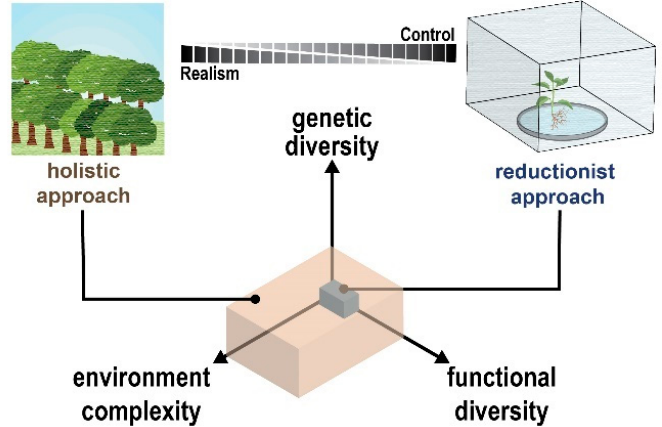
Figure 2. Dimensions of complexity and diversity in plant–microbe interactions. Studying plant– microbe interactions in both reduced and highly complex biological systems is necessary to obtain a complete understanding of these complex relationships. As complexity increases, the completeness and reliability of omic technologies will be challenged.